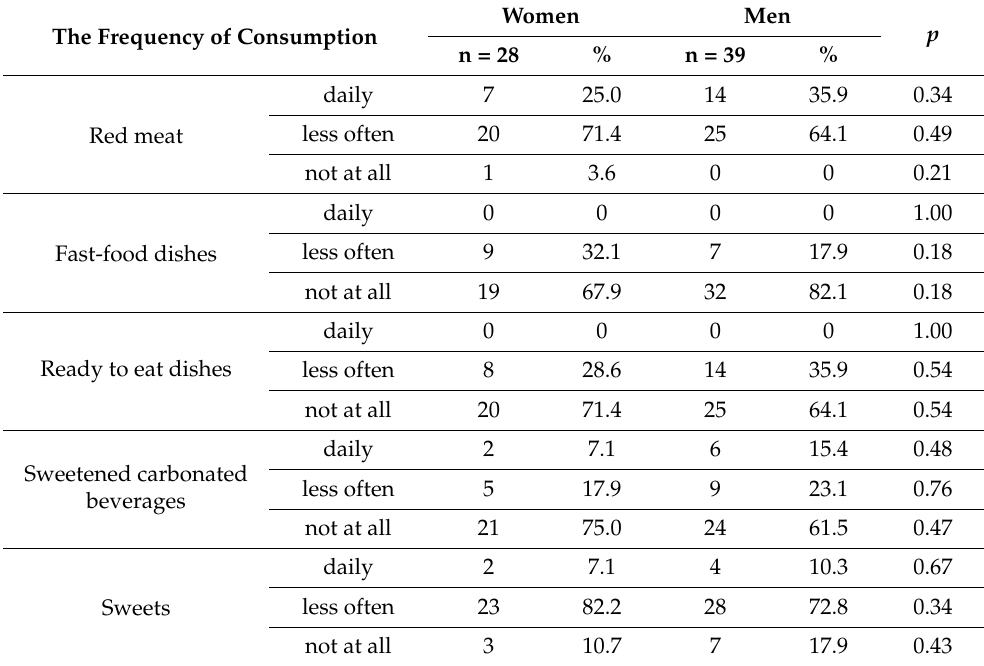
Table 6. Consumption rates for food products not recommended in the study group of patients by gender (n = 67).